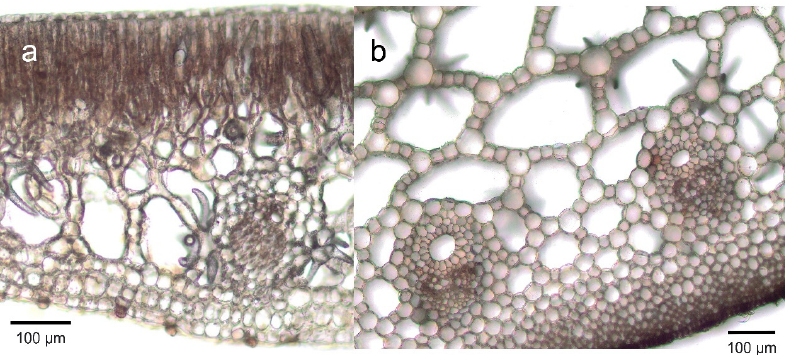
Figure 3. Transection of ( a ) natant leaf and ( b ) petiole of Nuphar luteum . Photo: Matej Holcar.